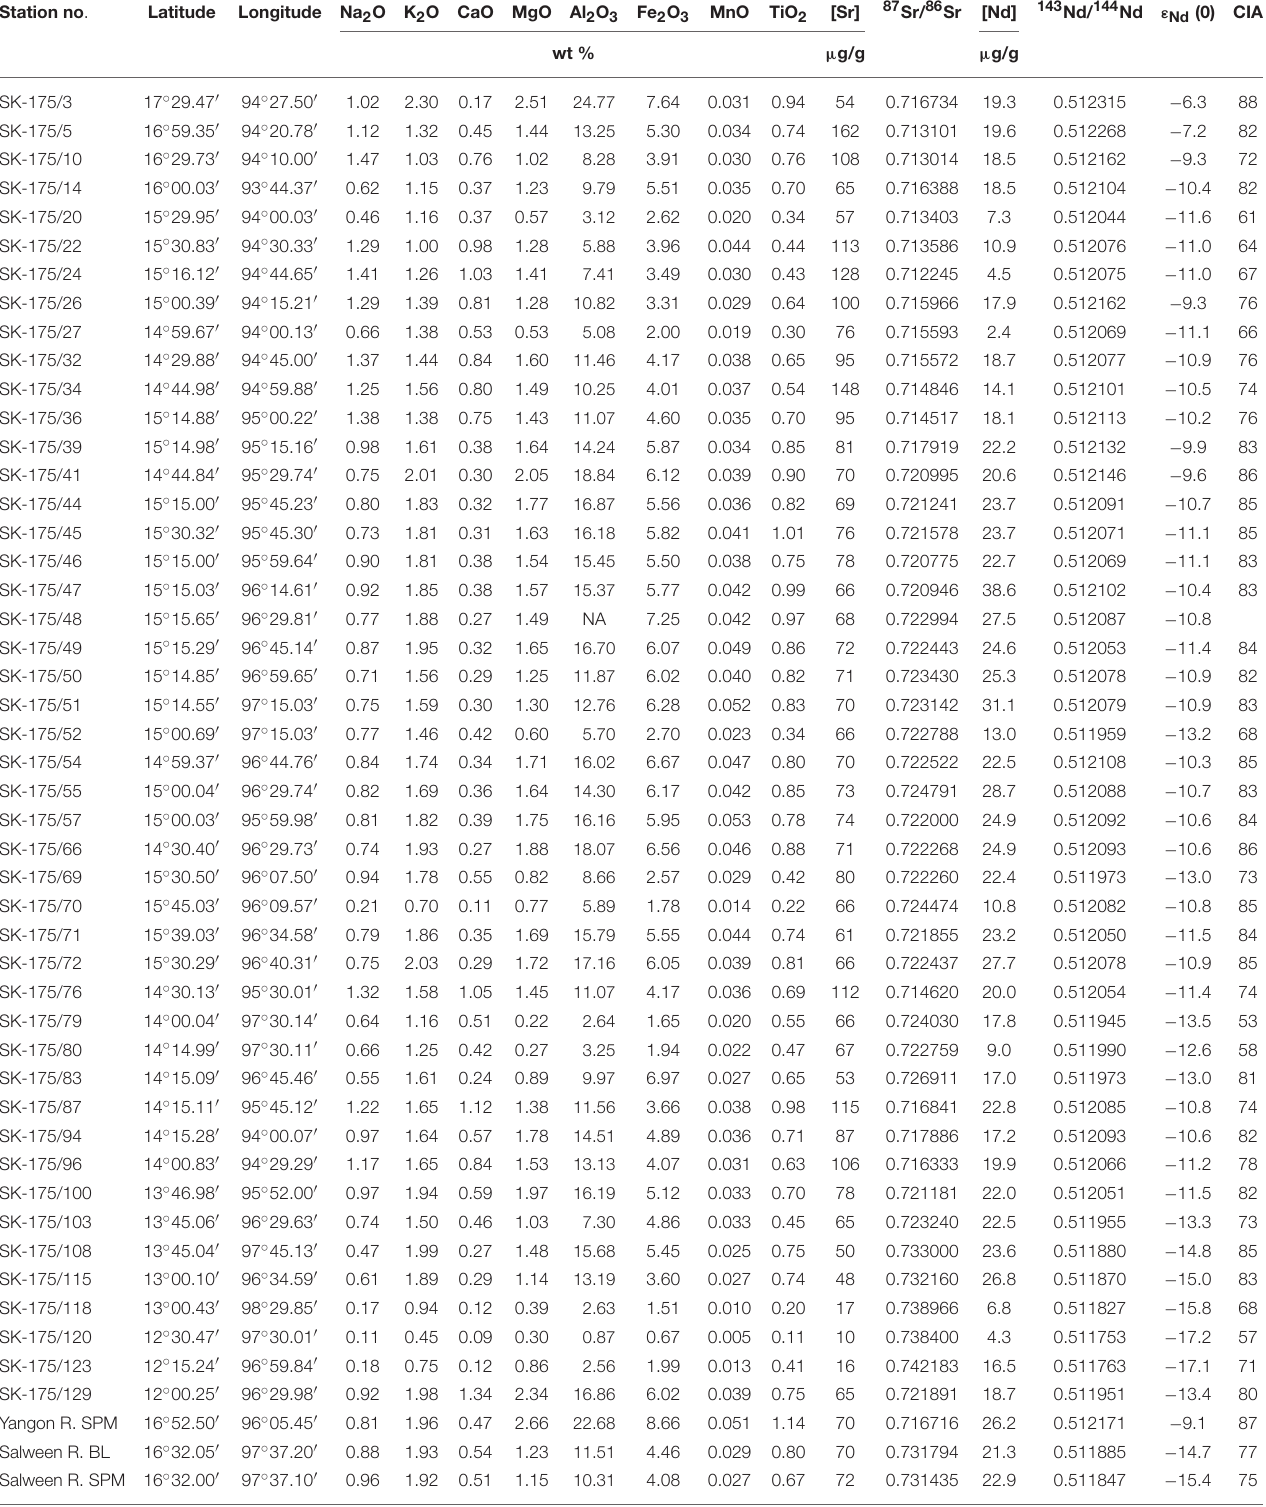
TABLE 1 | Sample locations, major element compositions, concentrations, and isotope compositions of Sr and Nd and Chemical Index of Alteration (CIA) in surface sediment samples from the Irrawaddy continental shelf, Northern Andaman Sea and the Irrawaddy and the Salween Rivers. Station no